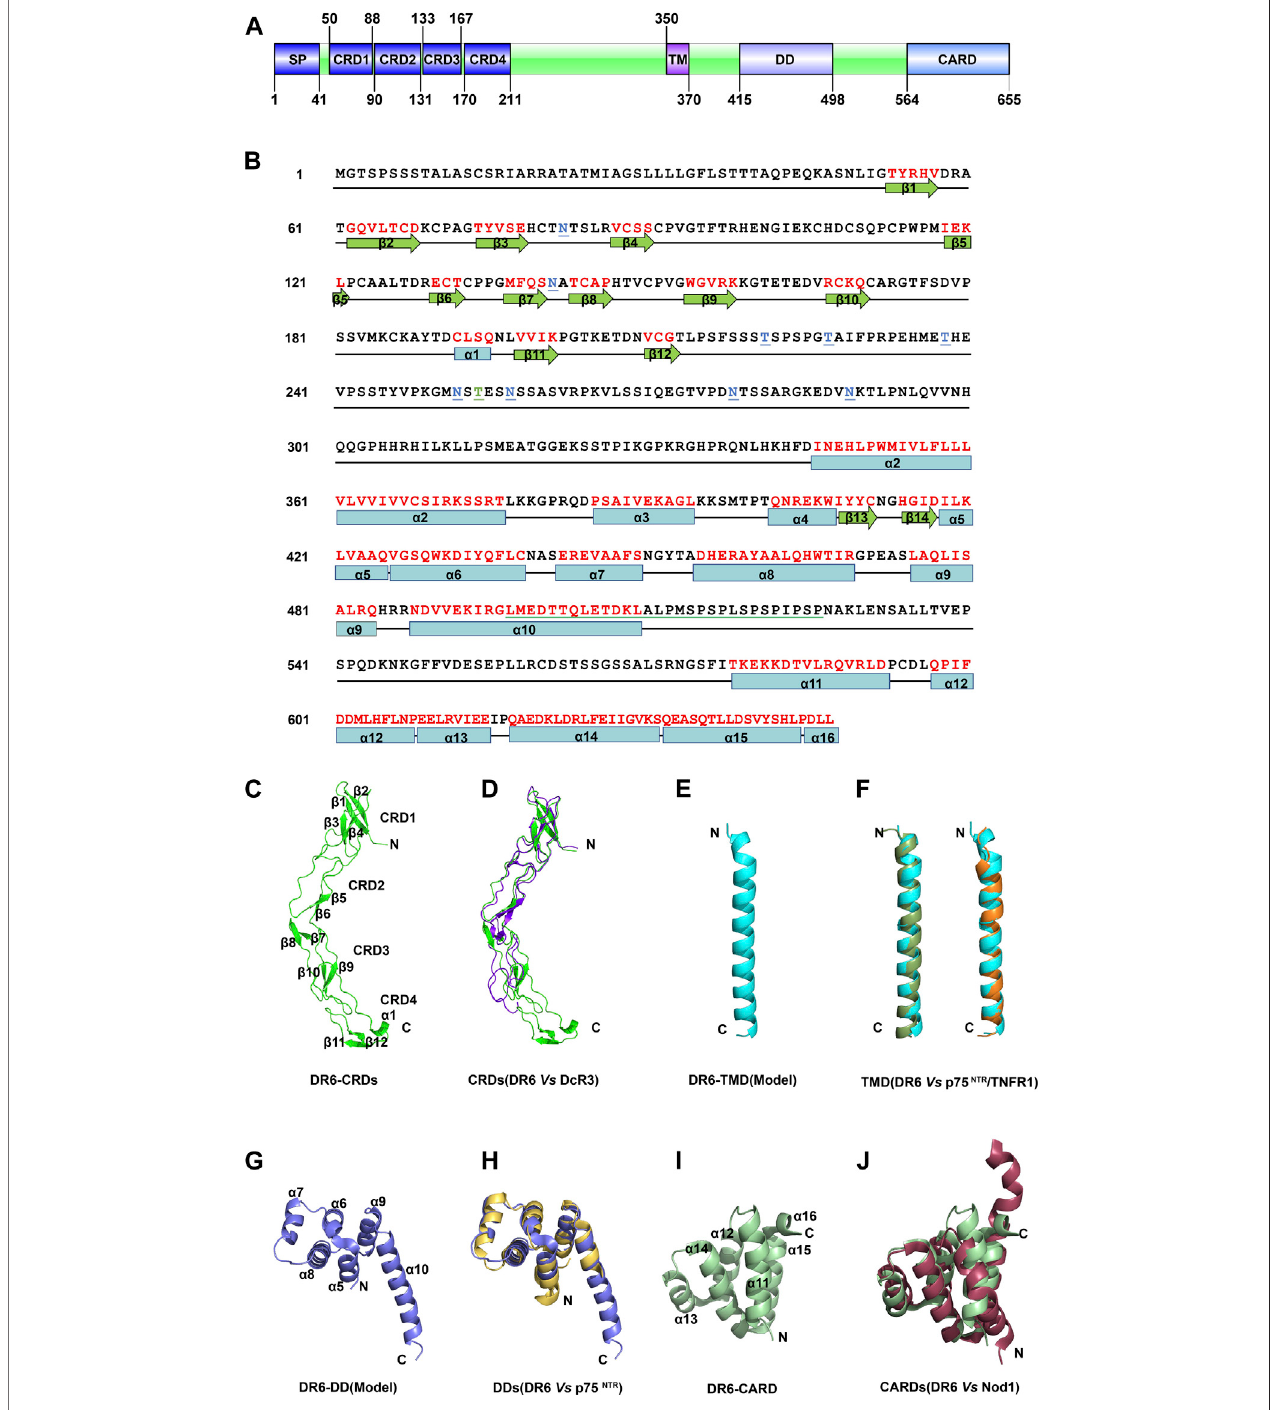
FIGURE 1 | The structure of DR6 (A) Molecular architecture of human DR6. SP: signal peptide; CRD: cysteine-rich domain; TM: transmembrane sequence; DD: death domain; CARD: caspase activation and recruitment domain. (B) Amino acid sequence of full-length human DR6. The secondary structures of DR6 are shown below the sequence. The red letters indicate the structured elements. N-glycosylation sites are colored in blue and underlined; O-glycosylation sites, green and underlined. A putative leucine zipper motif with a proline-rich sequence is green underlined (C) Ribbon drawing of crystal structure of the DR6-CRDs (PDB ID: 3QO4) (D) Structural comparison between CRDs of DR6 (green) and DcR3 (purple, PDB ID: 3MHD) (E) Structural model of the DR6-TMD. (F) Structural comparison between monomeric TMDs of DR6 (cyan) and p75 NTR (dark green, left, PDB ID: 2MIC)/TNFR1(orange, right, PDB ID: 7K7A) (G) Structural model of the DR6-DD. (H) Structural comparison between DDs of DR6 (blue) and p75 NTR (yellow, PDB ID: 4F42) (I) Ribbon drawing of the lowest energy structure of C-terminal CARD domain of DR6 (PDB ID: 2DBH) (J) Structural comparison between CARDs of DR6 (green) and Nod1 (dark red, PDB ID: 2NZ7).